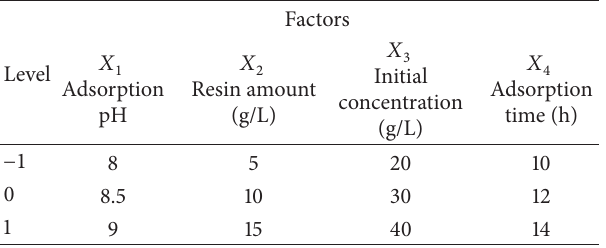
Table 1: Factors and levels of response surface